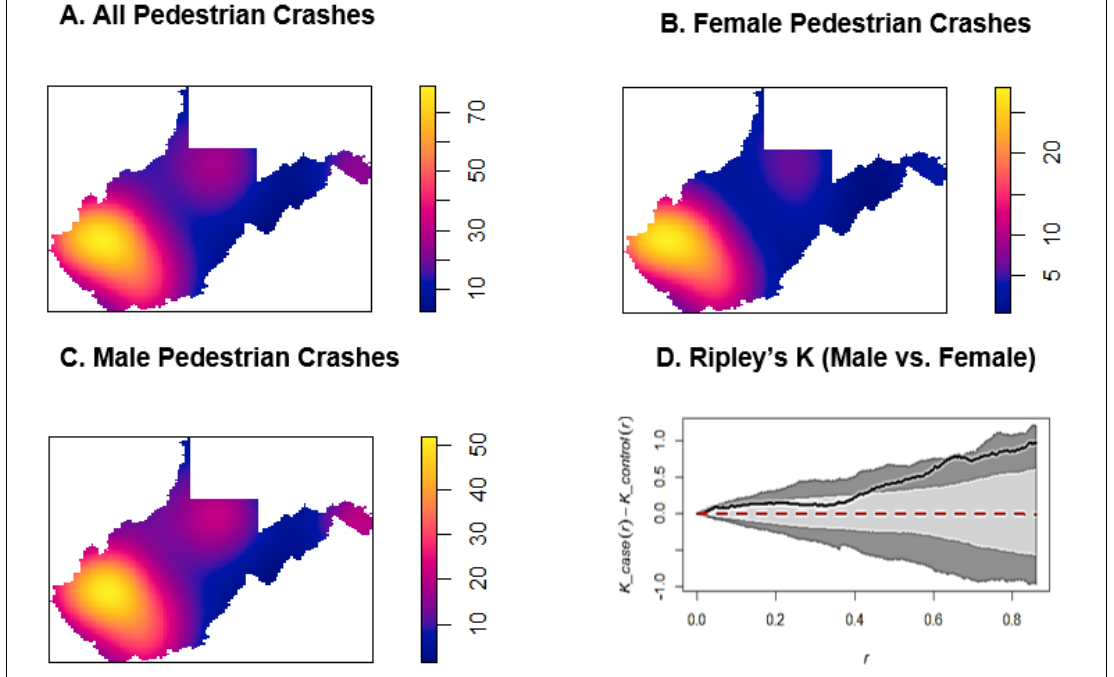
Figure 1. Kernel density estimations (KDEs) of all pedestrians, male, and female crashes along with Ripley’s K comparing intensity of clustering between male vs. female crashes in West Virginia, 2009–2019. Upper-left ( A ): KDE of all pedestrian crashes. Upper-right ( B ): KDE of female pedestrian crashes. Lower-left ( C ): KDE of male pedestrian crashes. Lower-right ( D ): Ripley’s K comparing intensity of clustering between male and female crashes. For the KDE (panels ( A – C )), areas of purple have lower numbers of fatal crash sites, and bright yellow have a higher number of crash sites.